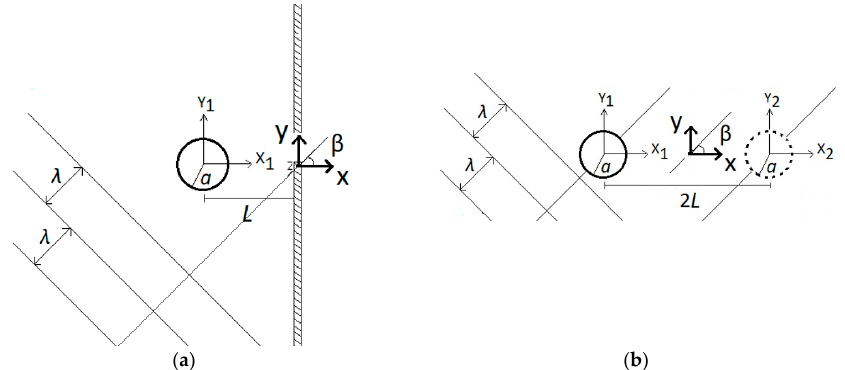
Figure 10. 2-D representation of a vertical cylindrical floater in front of a linear vertical breakwater: ( a ) plan view of the floater-breakwater system; ( b ) floaters’ representation in the image method (the image device is denoted dashed).